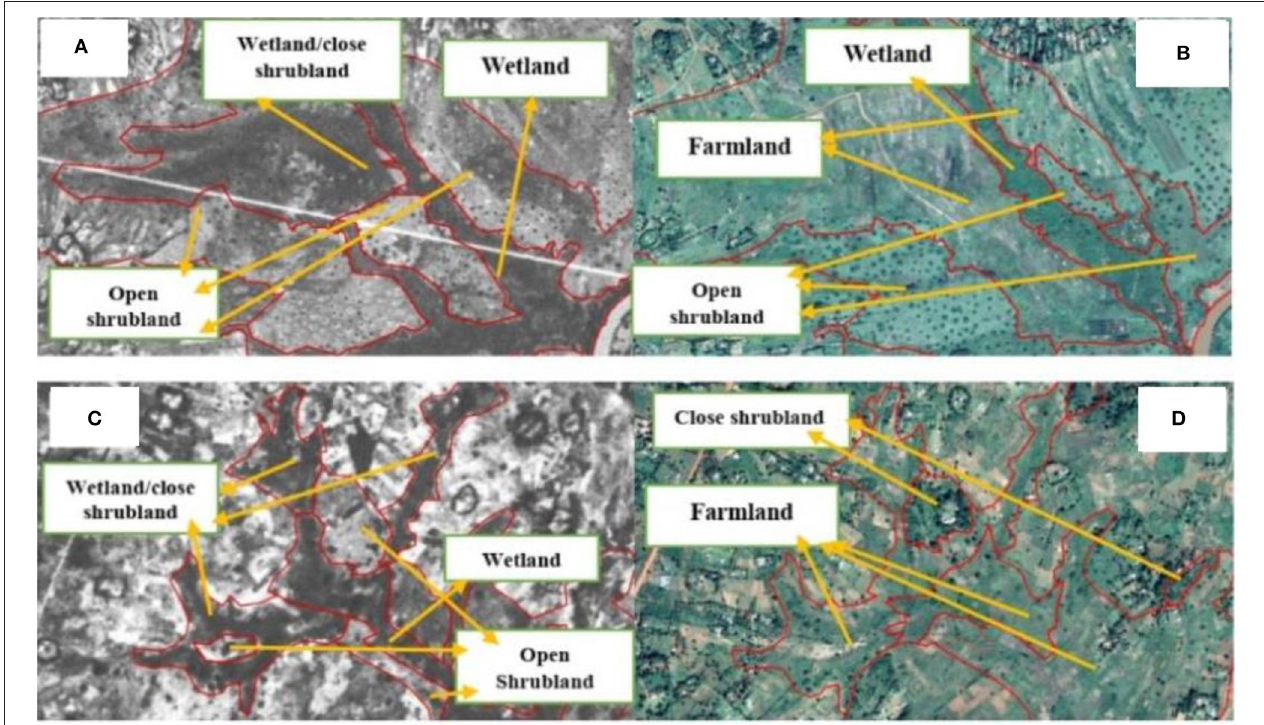
FIGURE 2 | Land use/cover types of the wetland and its surrounding as visually interpreted for CORONA (A,C) for 1966 image and Google Earth true color image data (B,D) for 2016/18.